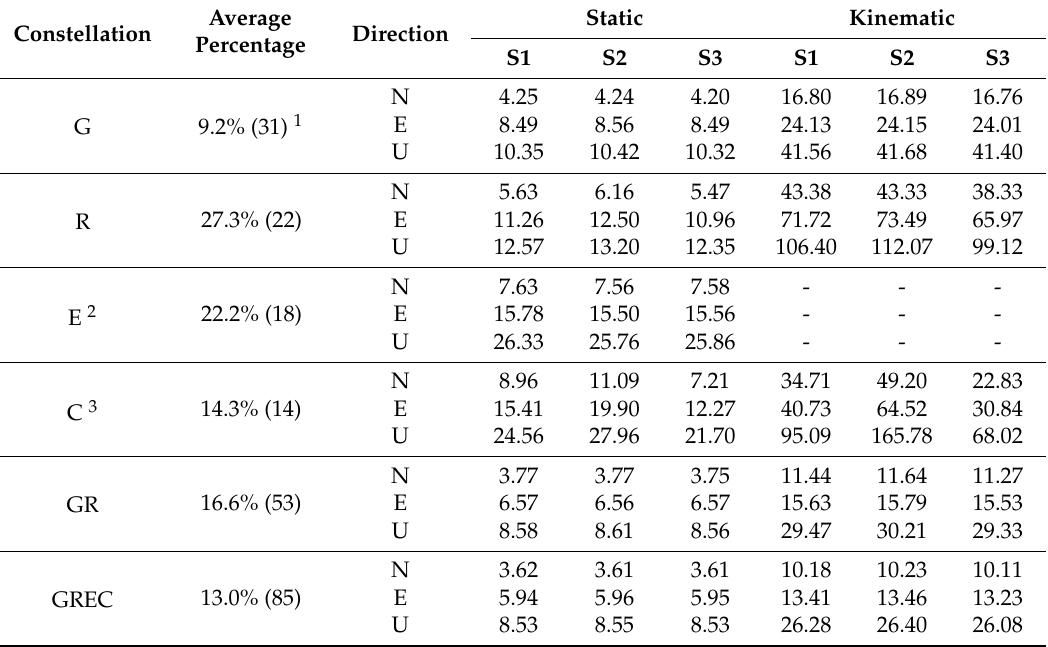
Table 6. The average RMS values (mm) under different